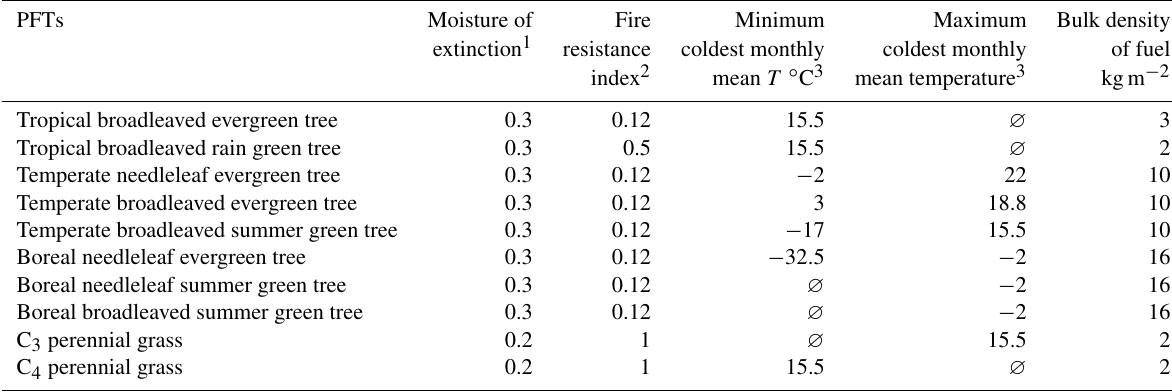
Table 1. Five of the 35 parameters defined for each of the 10 SEVER PFTs.